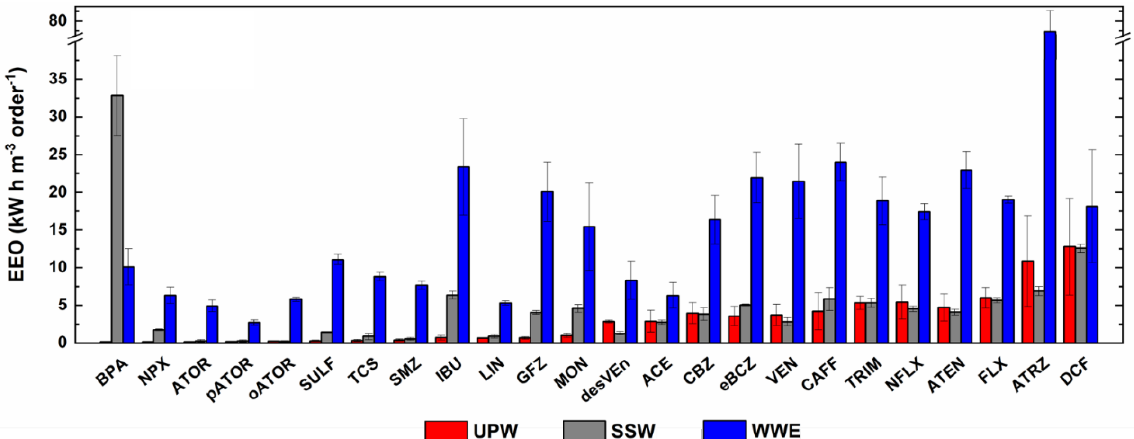
Figure 5. Values of electrical energy per order (EEO) required for removing PPCPs in ultrapure water (UPW), synthetic surface water (SSW), and wastewater effluent (WWE).